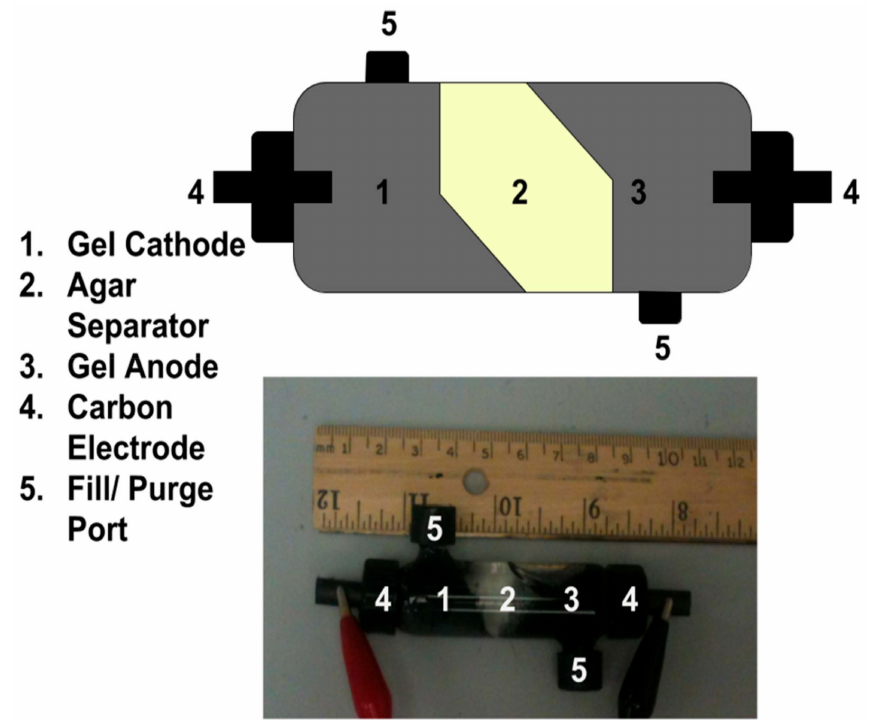
Figure 4. Closed gel Leclanch é cell construction in an 11 mL glass chamber with ports for purge / filling and ports for current